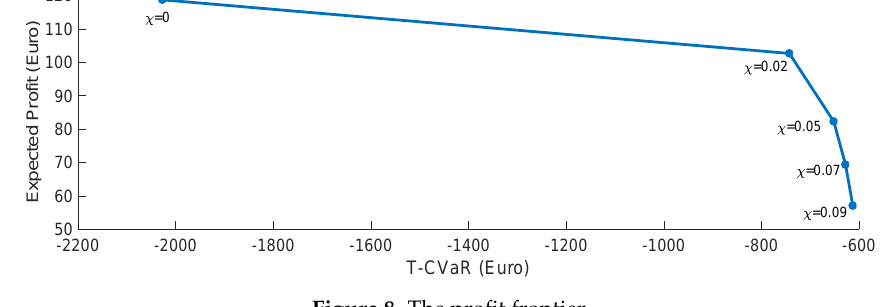
Figure 8. The profit frontier.